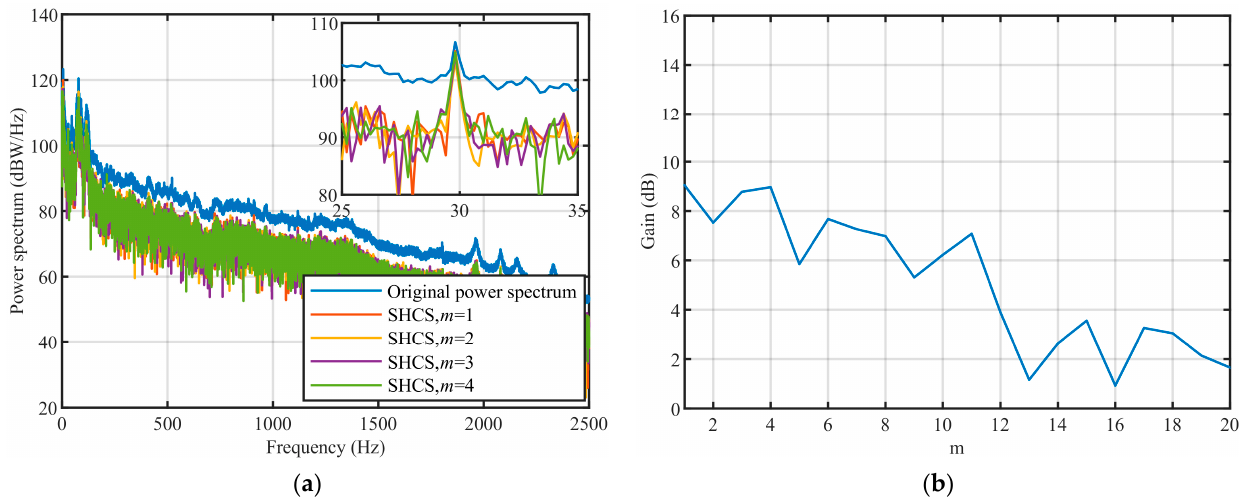
Figure 11. SHCS processing results for the Zhongsu 19 radiated noise: ( a ) power-spectrum estimation; ( b ) gain.